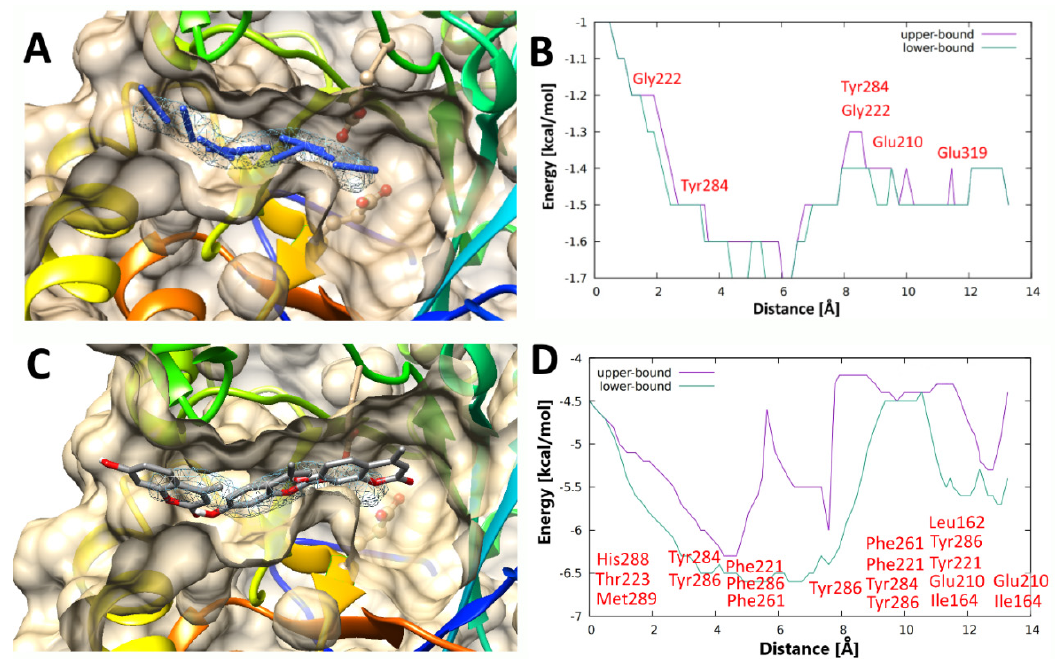
Figure 6. Selected snapshots of ( A ) the best (azide, 4 ) and ( C ) the worst (4-methylumbelliferone, 9 ) acceptors passing through the second tunnel of An Rut. At a specific point close to the entry to the tunnel, most acceptors form a temporary hydrogen bond with the peptide carbonyl of Gly222 residue (2.2 Å distance). Thus, Gly222 could be the major driving force attracting the acceptor molecule and dragging it into the tunnel. The respective energy profiles of acceptor passages are shown in panels ( B ) (for 4 ) and ( D ) (for 9 ). The lower-bound trajectory (green) is not contiguous; however, it samples the tunnel without any gap in the substrate movement and some bottlenecks may not be detected. The upper-bound trajectory (magenta) is contiguous, it is the best trajectory found; however, a trajectory with better energy profile may exist, the actual energy would then be the same or lower. During the acceptor (azide, 4 or 4-methylumbelliferone, 9 ) passage through the side tunnel, non-covalent interactions of amino acid residues (indicated in red in panels ( B , D )) with respective acceptors were monitored.